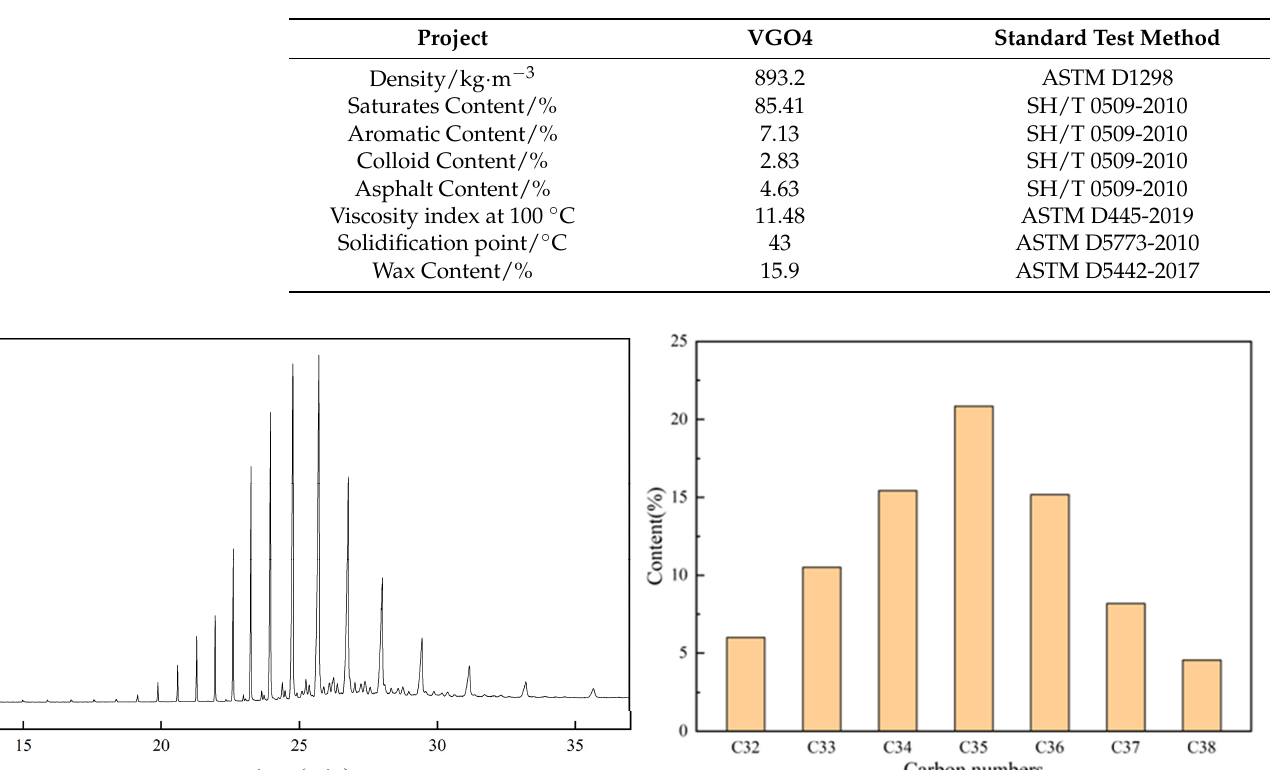
Table 1. The distribution of the carbon numbers of paraffin in VGO4 is shown in Figure 1, Table 1. Properties of VGO4. which are measured by the pyrolysis of a gas chromatography-mass spectrometer. Table 1. Properties of VGO4.